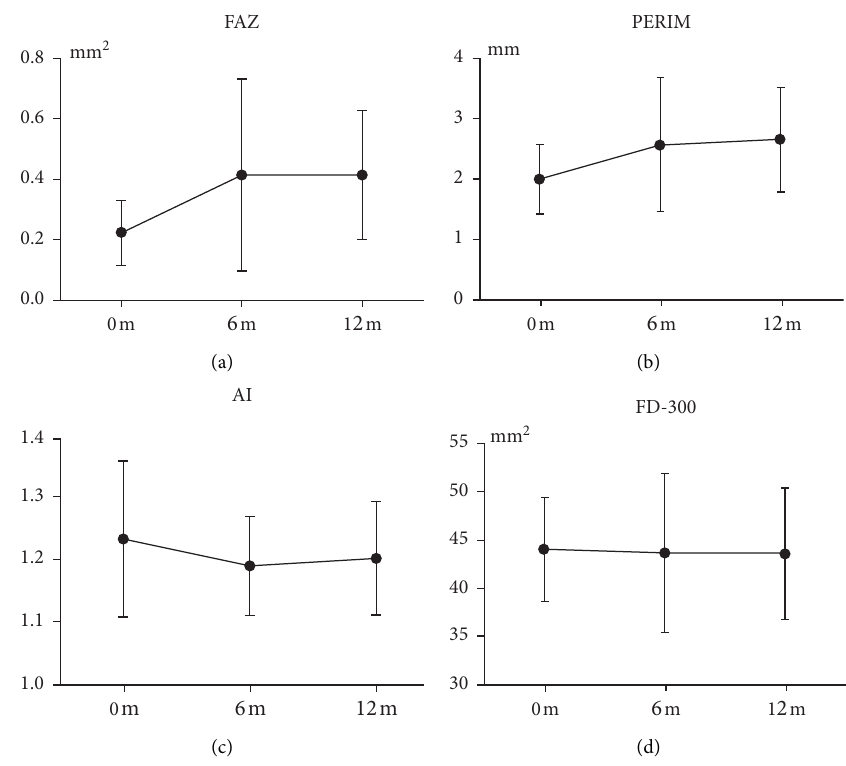
Figure 1: Changes in FAZ, PERIM, AI, and FD-300 within 12 months. FAZ, foveal avascular zone; PERIM, FAZ perimeter; AI, acircularity index; FD-300, the VD within a 300 μ m wide ring surrounding the FAZ. Table 3: Differences in macular vascular density at month 6 and month 12 from baseline. Month Characteristics No. After-before difference between months 95% CI P value After